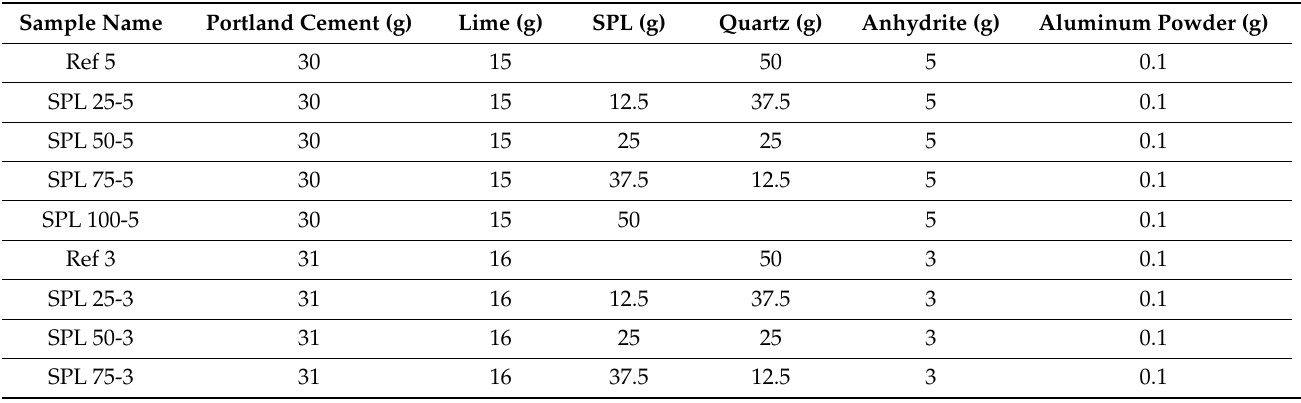
Table 2. Binder mixtures for the synthesis of autoclaved aerated concrete (AAC) blocks. The complete AAC mixture included 100 g of demi-water.